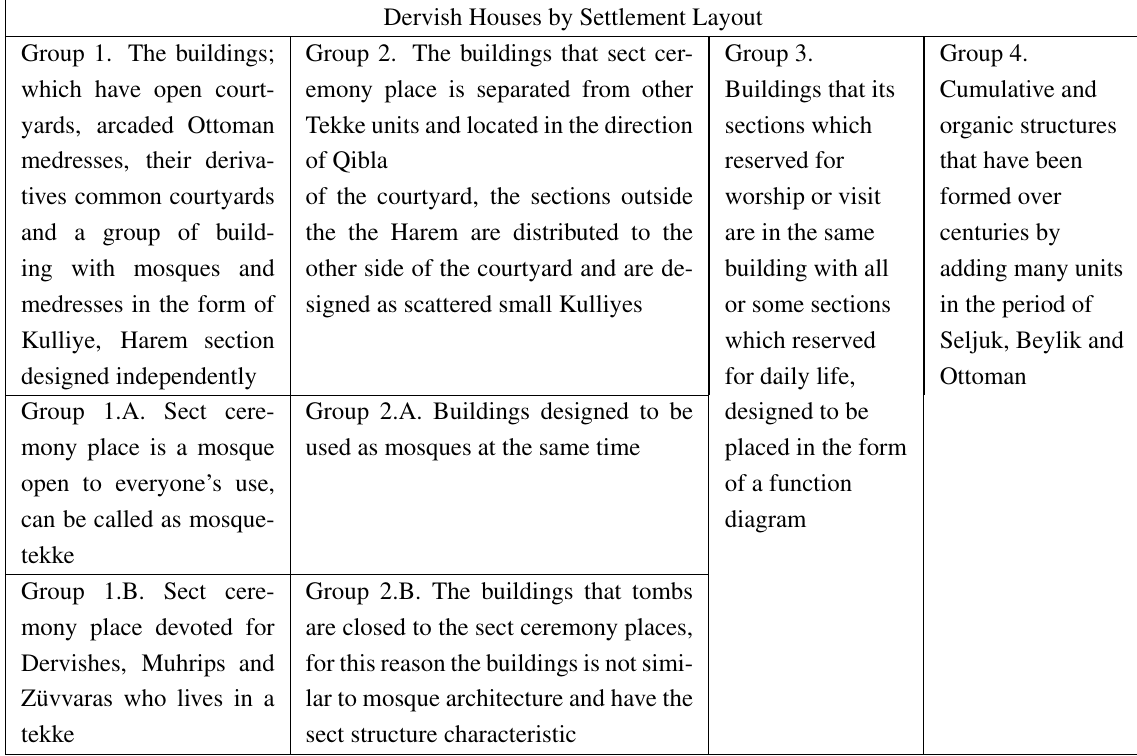
Table 1. Classification of the Dervish Lodges According to the Settlement Layout (Tanman,